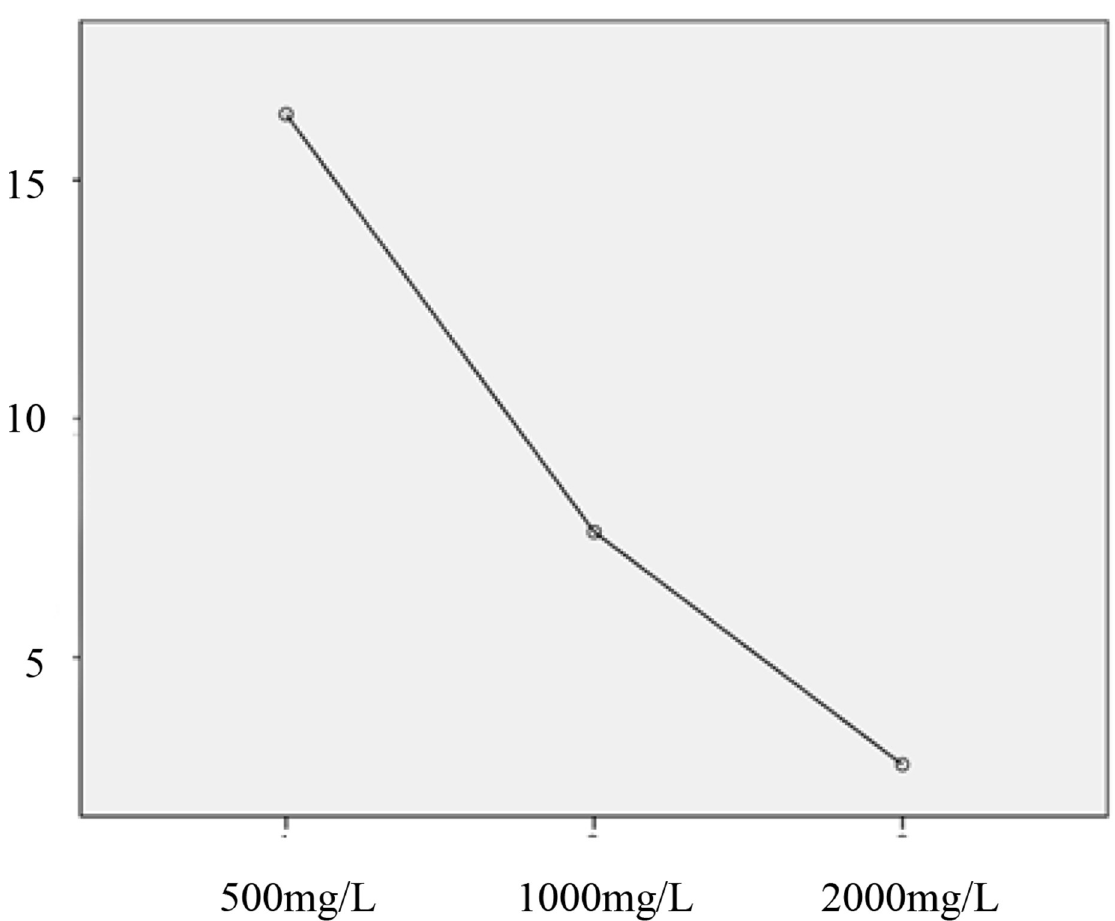
Fig 1. Test mean plot. The mean value diagram of bioluminescence assay for high-frequency objective indicators with different concentrations.